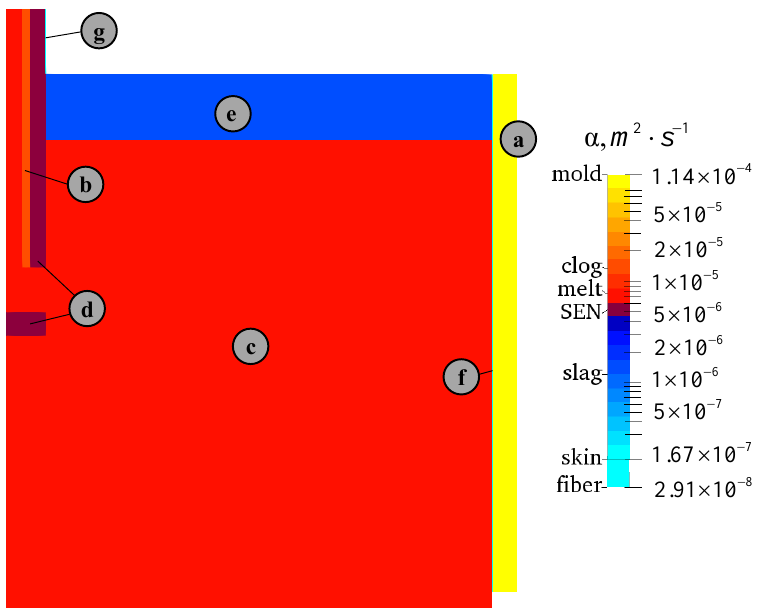
Figure 4. Thermal diffusivity α of the casting system components (in descending order): ( a ) mold, ( b ) clogging material, ( c ) liquid melt, ( d ) refractory, ( e ) liquid slag, ( f ) slag skin, and ( g ) SEN fiber insulation.